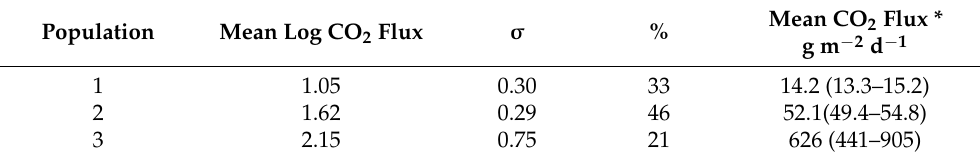
Figure 5. Probability plot of Log CO 2 fluxes. The entire dataset is reported with grey points while the background CO 2 fluxes are reported as blue symbols. The black lines represent the partitioned populations while the dashed red curve represents their mixture in the proportion reported in Table 3. Table 3. Statistical parameters of the individual partitioned